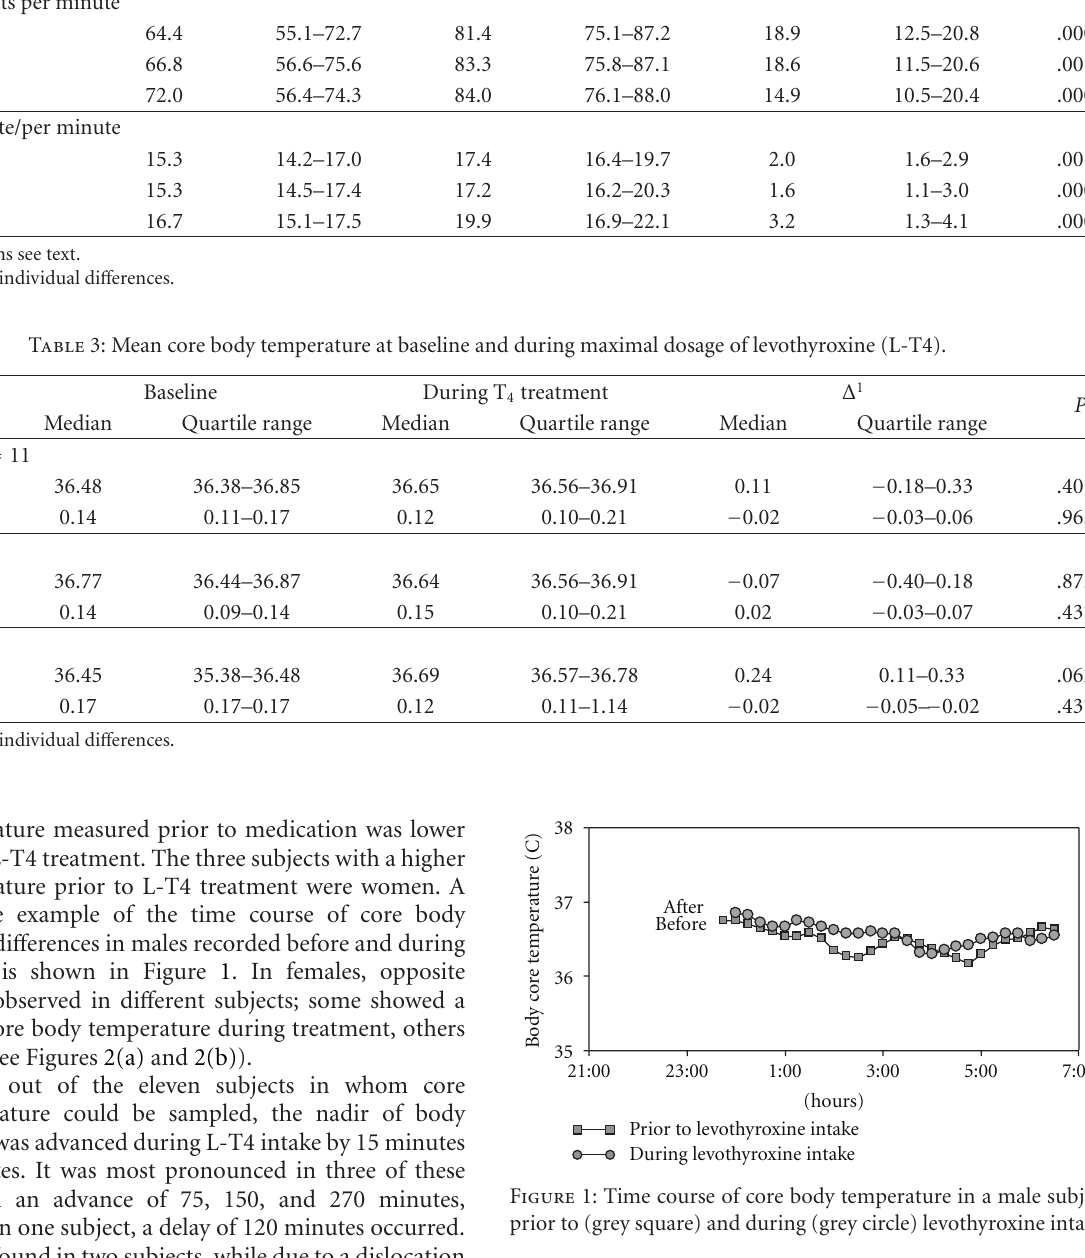
Table 2: Heart rate and respiration rate at baseline and during maximal dosage of levothyroxine (L-T4) 1 . Baseline Physiological parameter